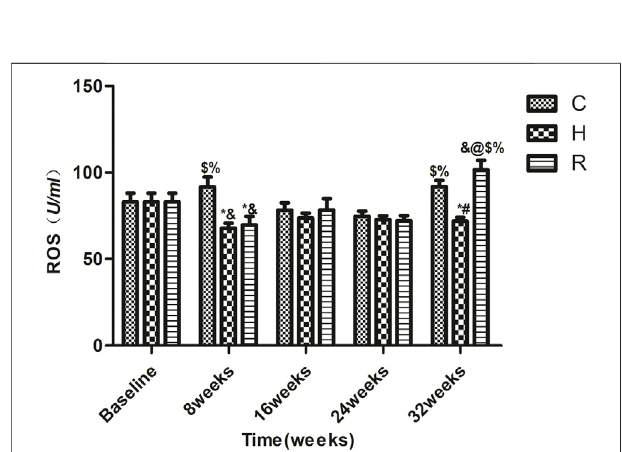
FIGURE 3 | The soleus muscle mass index of rats in each group. *Signi fi cantdifferentfromCandothergroup; # Signi fi cantdifferentfromHand R;&Signi fi cantdifferentfromBaselineandotherweeks;@Signi fi cantdifferent from 8 weeks and other weeks; $ Signi fi cant different from 16 weeks and other weeks; % Signi fi cant different from 24 weeks and other weeks ( p < 0.05).